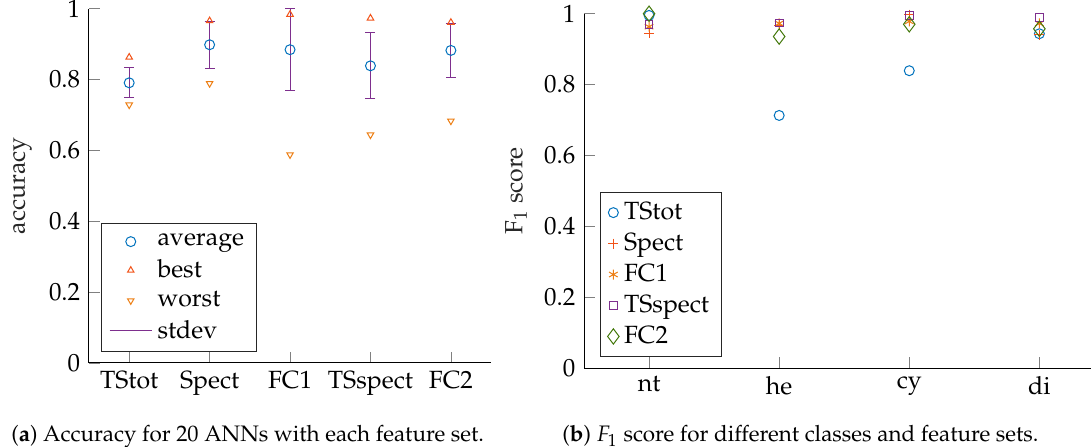
Figure 9. Performance measures for narrowband excitation (52kHz to 48kHz). Compare also Tables A5 and A6 in the Appendix A.